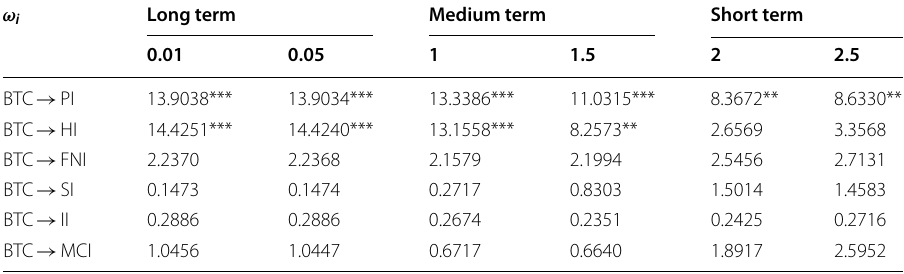
Table 11 Results of frequency domain causality test from Bitcoin to RavenPack coronavirus-related indices